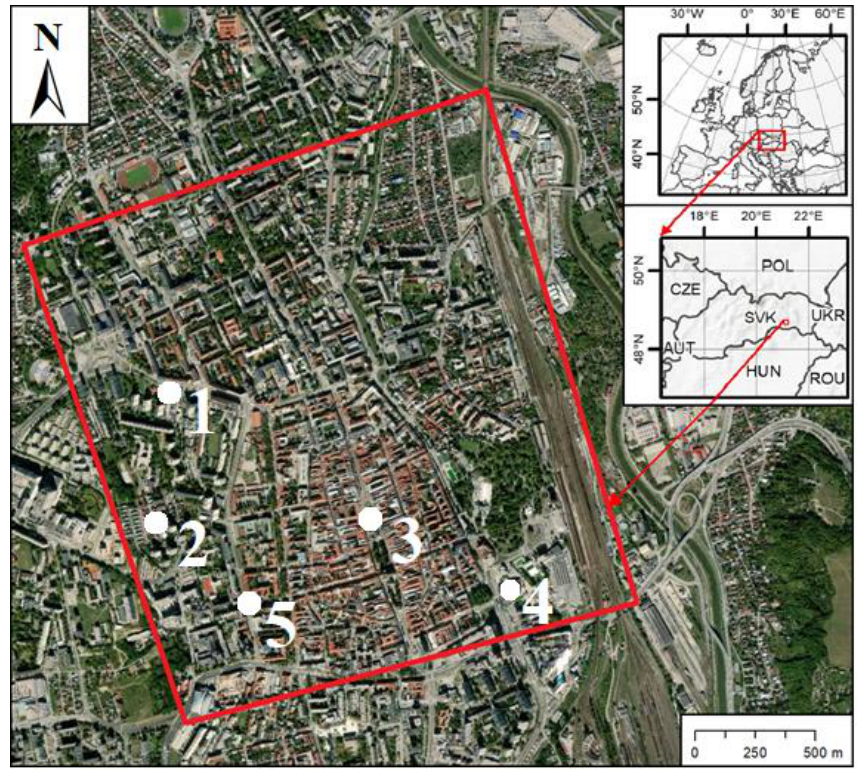
Figure 1. Location of the study area in the city of Košice, Slovakia.